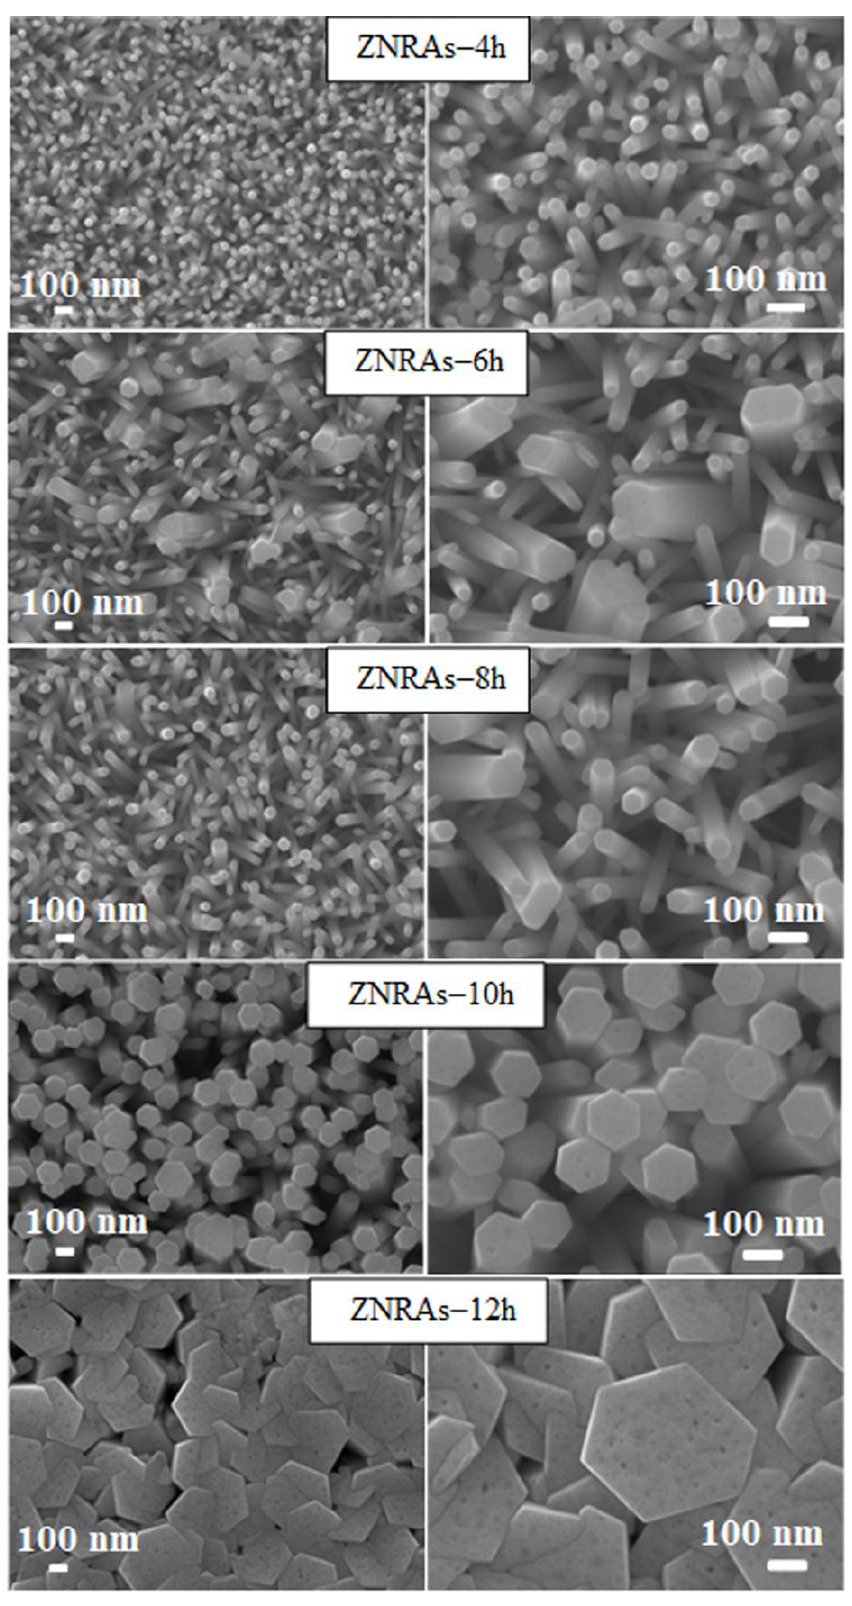
Figure 4. FE-SEM images (top view) of ZNRAs prepared at various hydrothermal growth times.